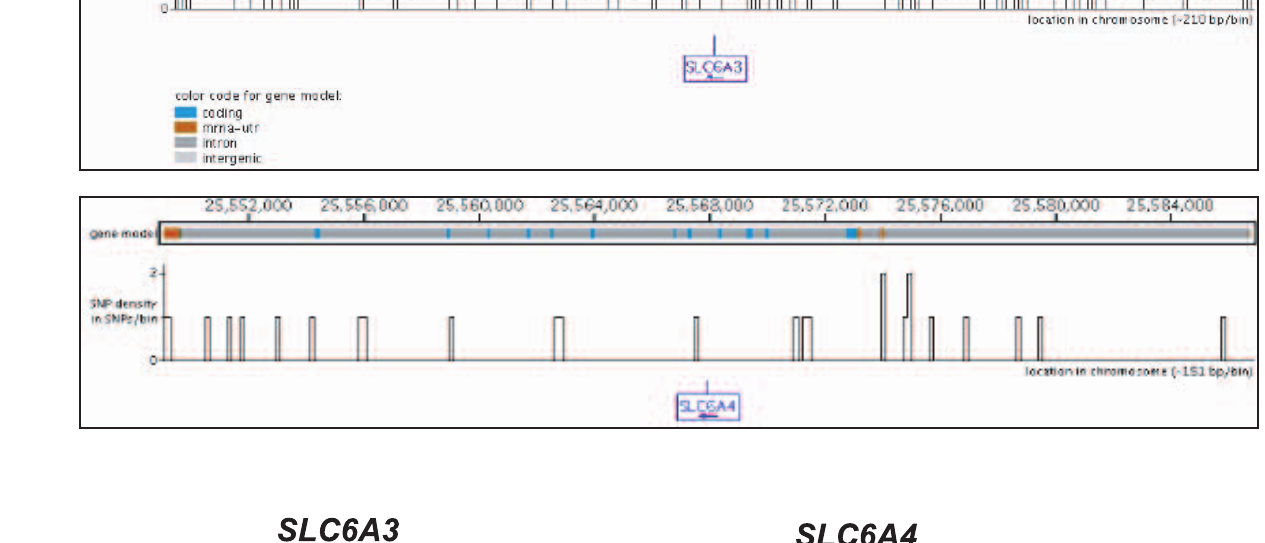
variation to the genome [46]. This genomic feature is highly prevalent: about 13% of human genes overlap with CNVs [47].